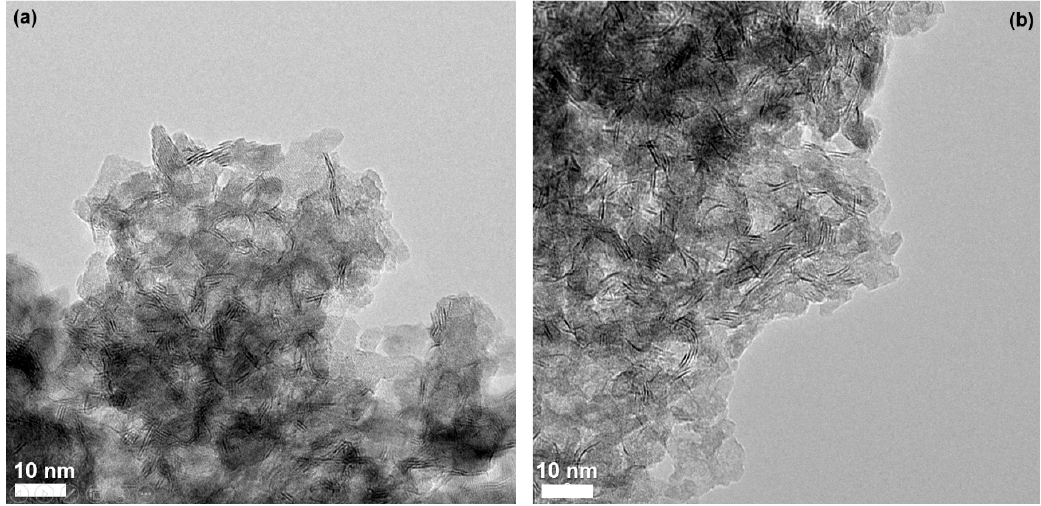
Figure 2. High-resolution transmission electron microscope (HRTEM) images of mesoporous sulfide catalysts: ( a ) CoMo/ γ -Al 2 O 3 and ( b ) NiMo/ γ -Al 2 O 3 .